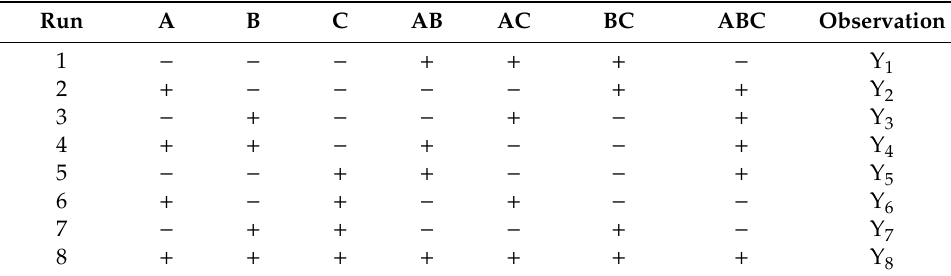
Table A2. 3 Factor design of experiments at high and low levels.